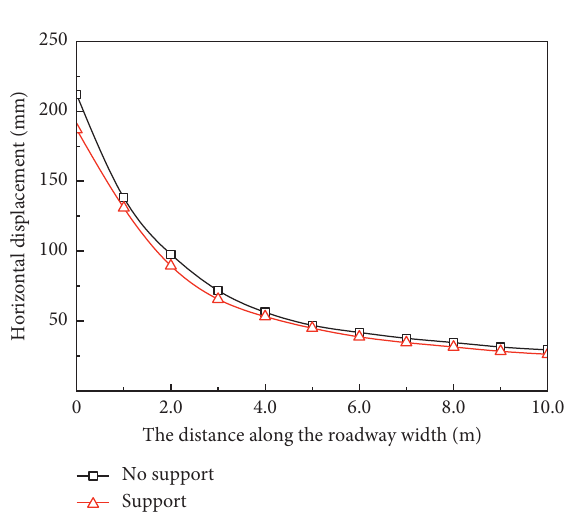
Figure 17: The horizontal displacement of the two sides of the roadway.